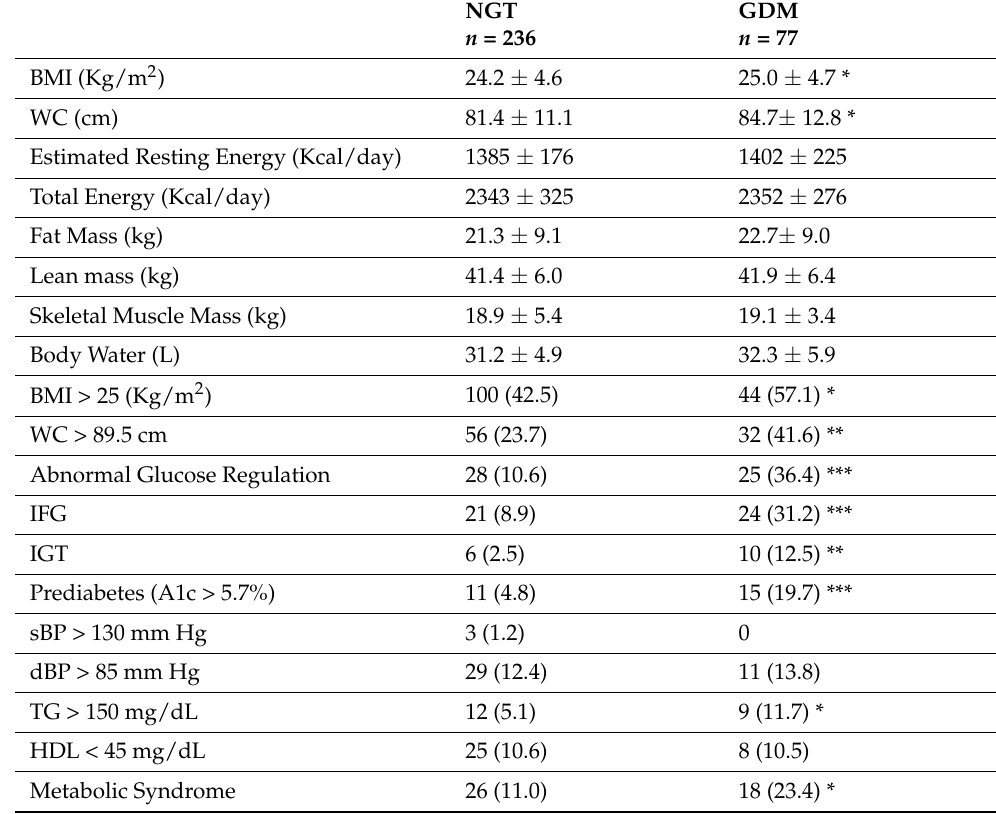
Table 6. Body composition and metabolic syndrome components, 2–3 years